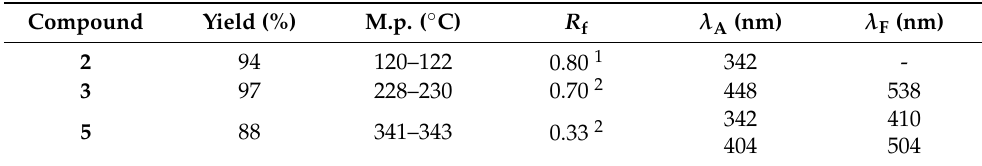
Table 1. Yields and characteristics of the synthesized compounds ( 2 , 3 , and 5 ) in water/DMF (3:1, v / v )